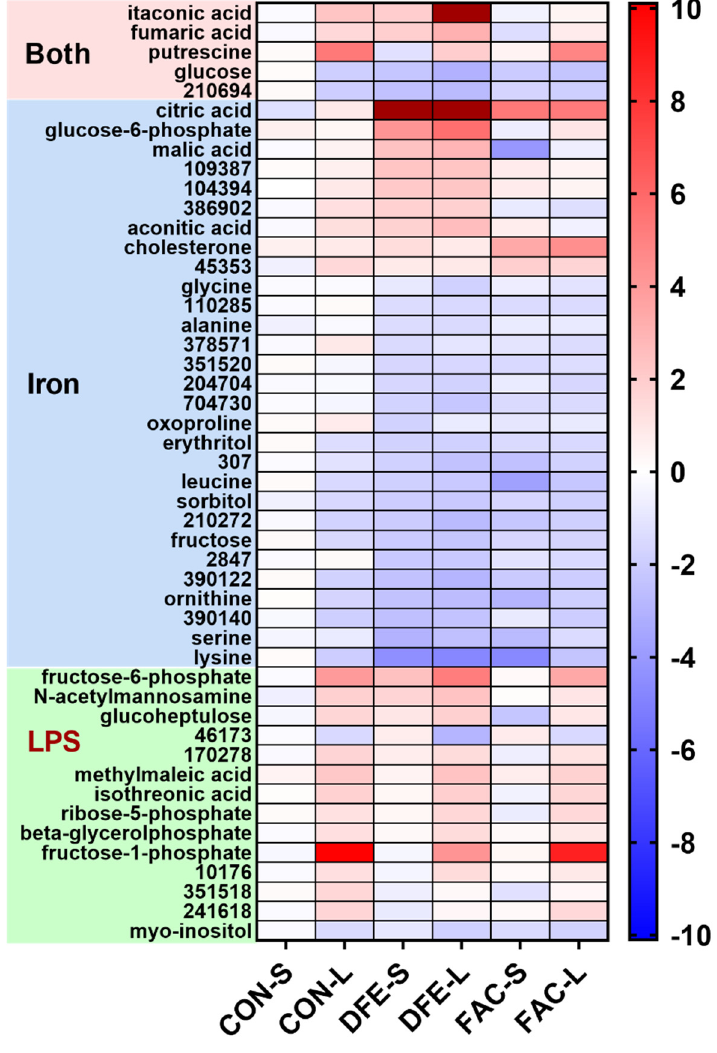
Figure 3. Untargeted metabolomics revealed 48 metabolites (28 identified) of PAMs that were altered by LPS (100 ng/mL, 6 h) challenge or pre-challenge exposure to deferiprone (DFE, 500 µ M, 24 h) or ferric ammonium citrate (FAC, 200 µ M, 24 h) or both effects. Results are presented as the fold change relative to the non-challenged control group (CON-S). CON-S, DFE-S and FAC-S: cells were pre-exposed to iron-replete control media, DFE-containing media, and FAC-containing media, respectively, and challenged with sterile PBS solution. CON-L, DFE-L and FAC-L: cells were pre-exposed to iron-replete control media, DFE-containing media, and FAC-containing media, respectively, and challenged with LPS.